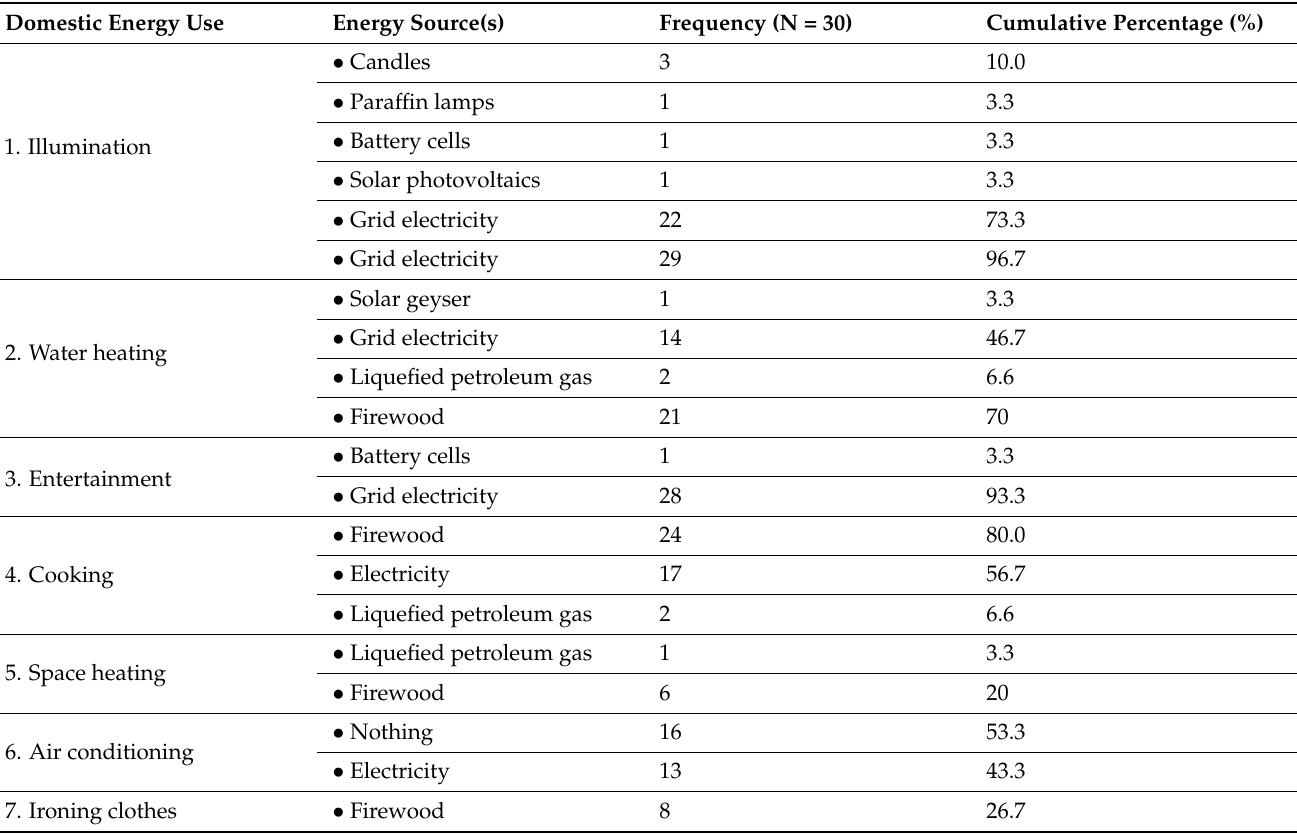
Table 2. Energy types and their uses in a household in the rural areas of the Vhembe